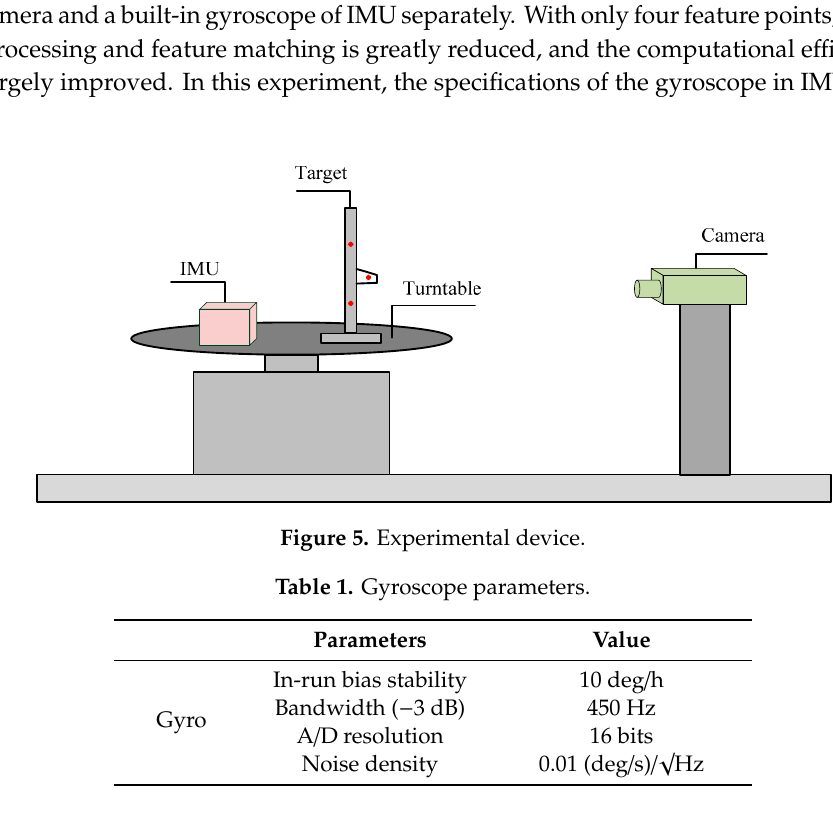
8 of 17 Figure 4. Processing of (a) RBF training with vision data; and (b) RBF prediction without vision data. IMU: inertial measurement unit. This research uses RBF to establish the network model by training attitude errors while the visual data are available and to compensate attitude by predicted errors without visual data. In the process of training, attitude errors are treated as the input of RBF. The errors are transferred to the weighting sum of output layer by the activation function in the hidden layer. In the process of